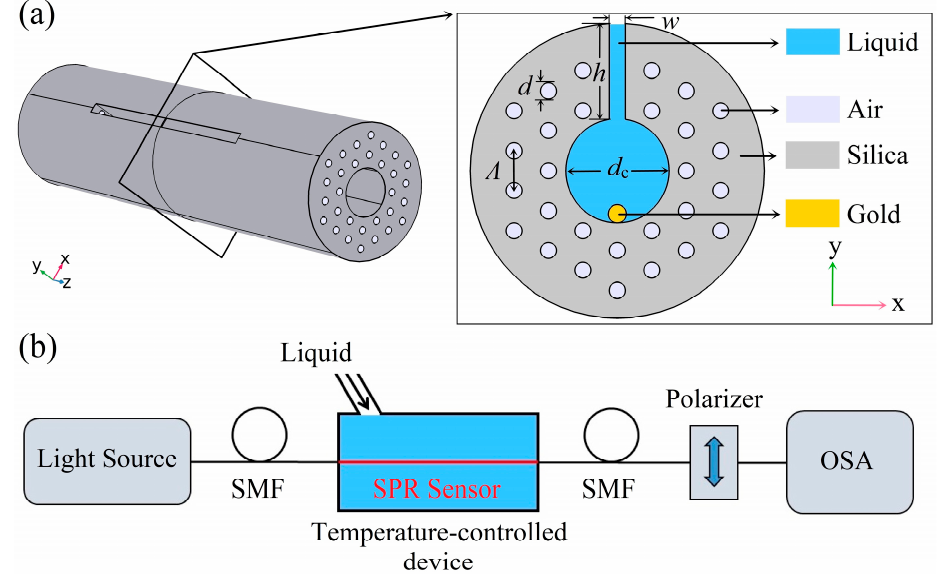
Figure 1. ( a ) Schematic diagram of the surface plasmon resonance (SPR) sensor based on a side opening hollow fiber and ( b ) experimental setup diagram of the proposed SPR sensor for temperature sensing.